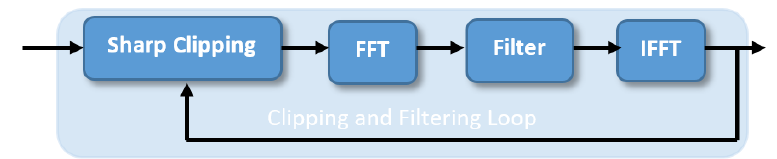
Figure 3. Example of conventional clipping and filtering